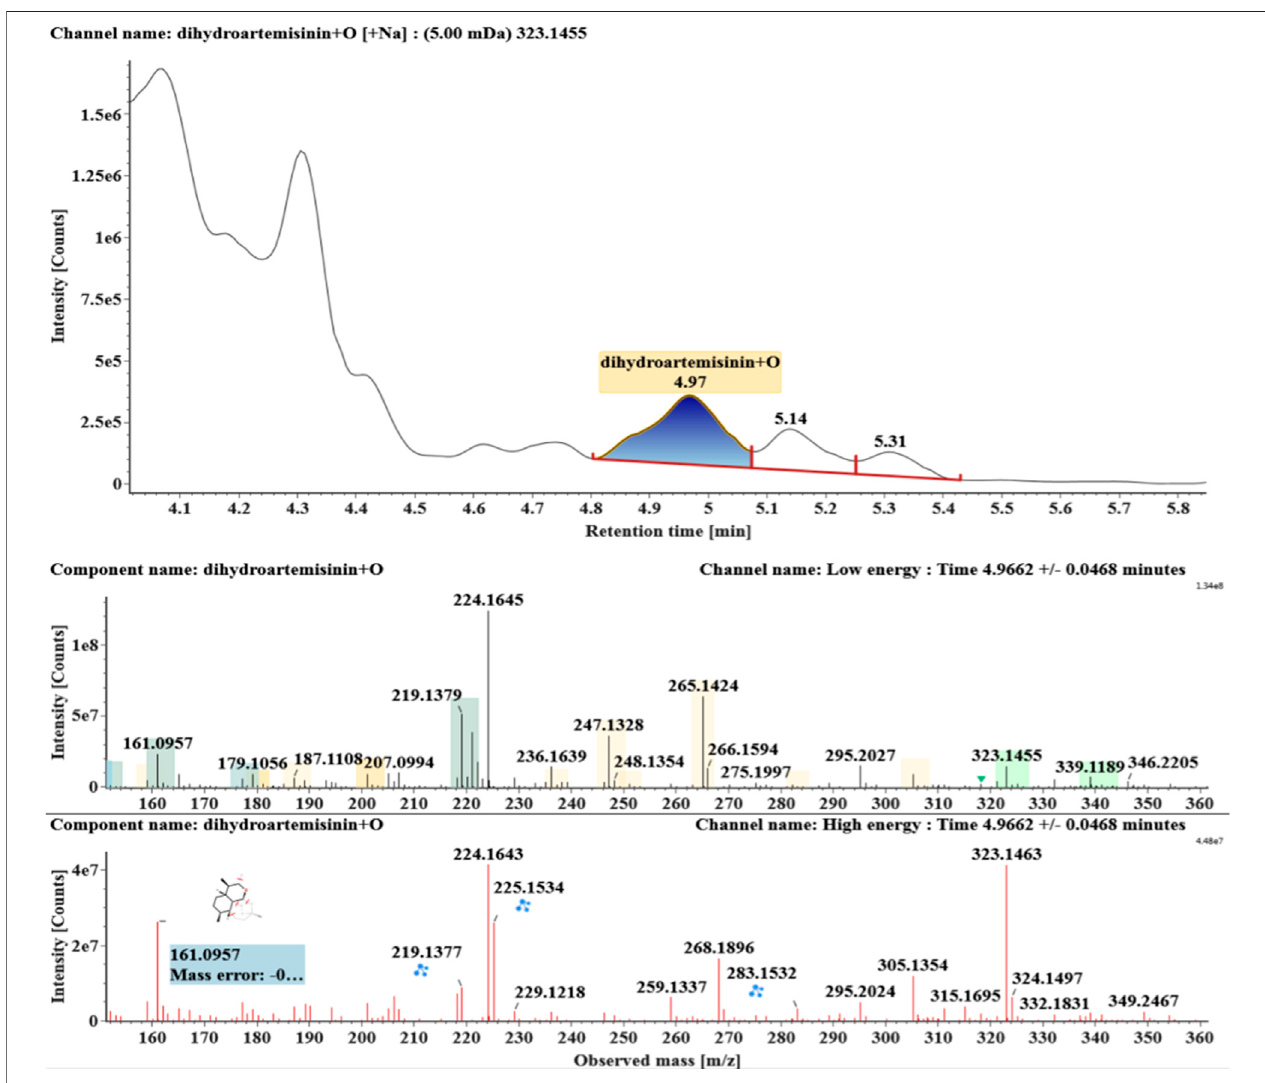
FIGURE 4 | Extracted ion chromatograms and mass spectrometry (MS E ) spectra of M3 .